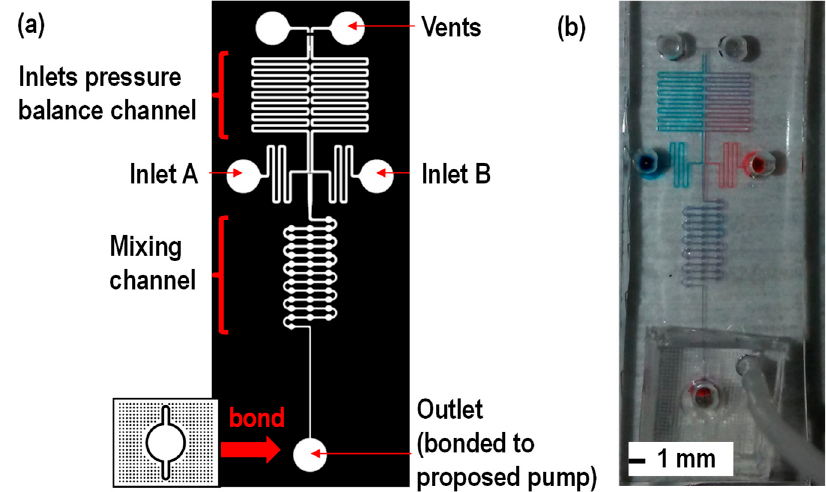
Figure 6. ( a ) Micromixing device channel design adopted from [12] and ( b ) experimental results. As one of the advantages of using the proposed device is that the proposed pump can be used for the operation of the device designed by [12]. In the test channel design [12], the micromixing channel design consists of two inlets, an inlet pressure balance channel for offsetting the pressure difference at inlets, the micromixing channel and the dead-end channel connected to the proposed pumping. The vent and the inlet pressure balancing channel were serving to offset the pressure difference between inlets A and B to avoid any backflow while sample mixing [12]. As shown in ( b ), micromixing of two samples was achieved with the proposed pump.